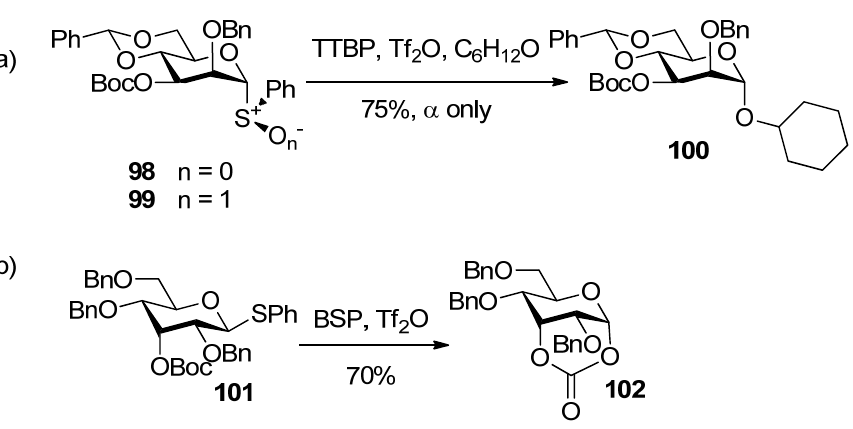
Scheme 17. Remote participation by non-vicinal